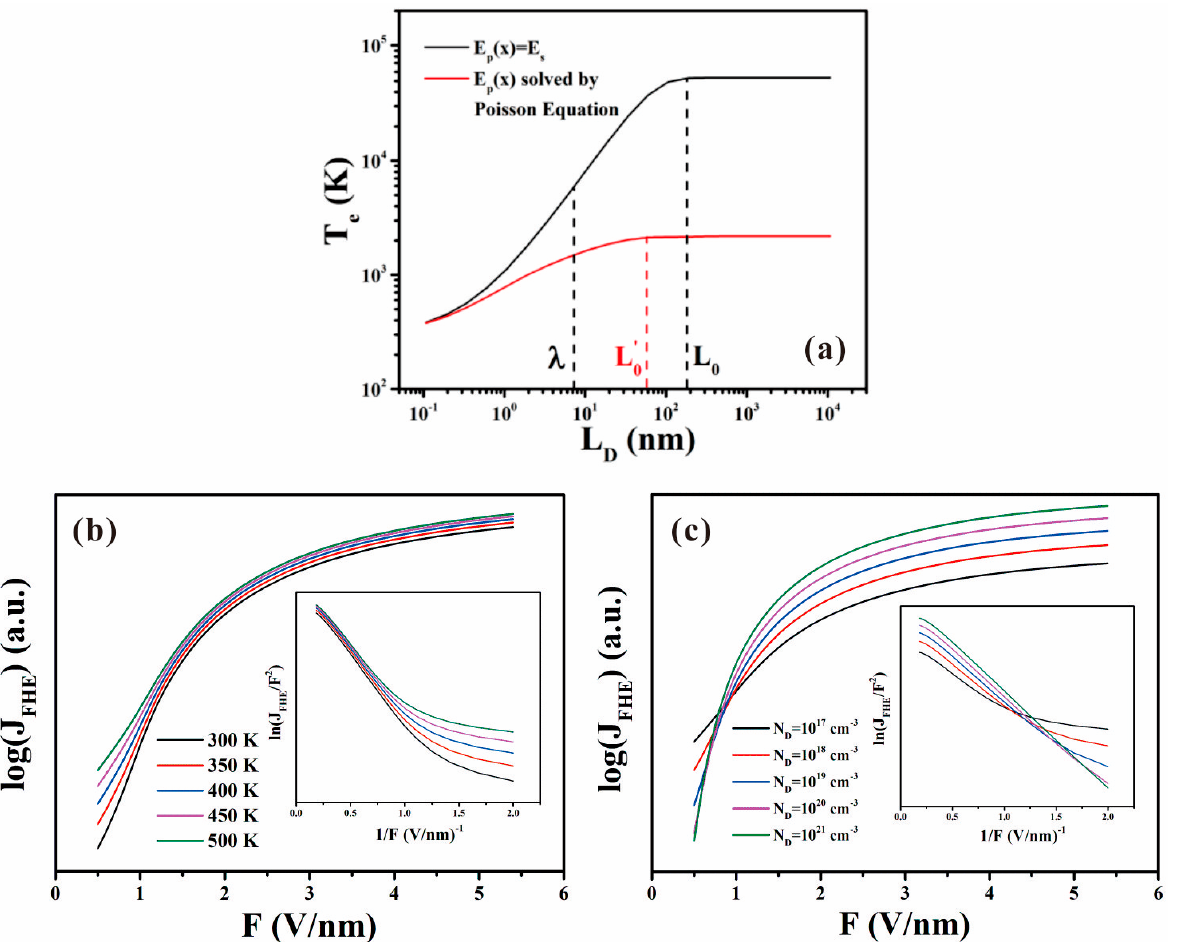
Figure 17. Calculation results based on penetration length-dependent hot electron emission model. ( a ) Simulated effective electron temperature as a function of the penetration length. ( b ) Simulated field emission characteristics under different temperature. ( c ) Simulated field emission characteristics with different carrier concentration. The insets in ( b , c ) are the corresponding FN plots. Reproduced from [82], with the permission of IOP Publishing, 2018.